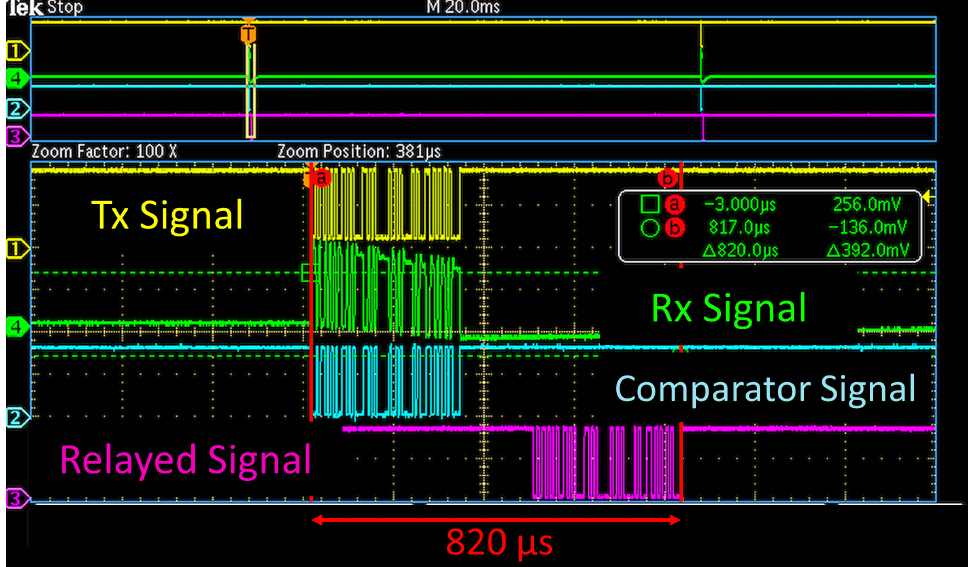
Figure 6. Beaconing: oscilloscope screen showing transmitted signal (yellow), received signal (green), digitized signal (blue) and relayed signal (purple). The beaconing interval is set much higher than the size of the